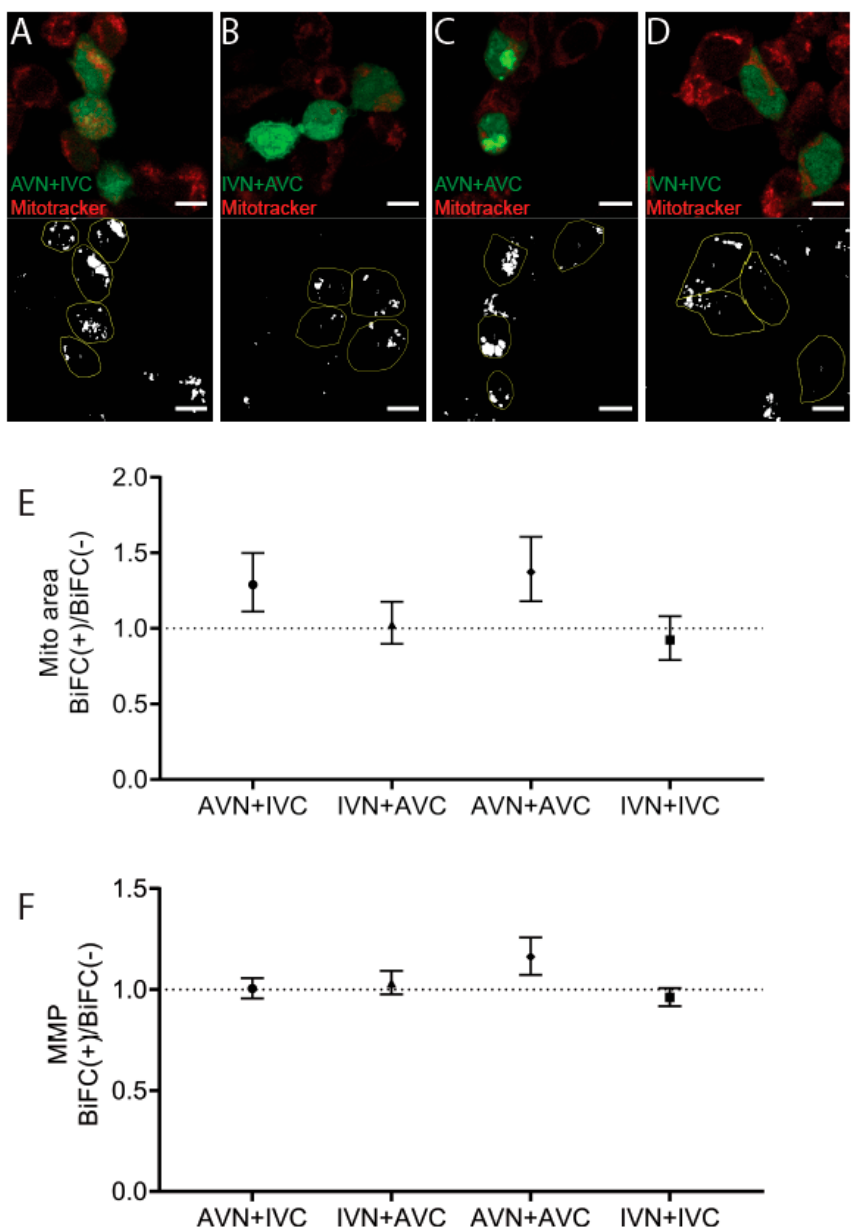
Figure 4. The expression of A β /A β increases the mitochondrial membrane potential. Confocal images of HEK293 cells transfected with ( A ) AVN + IVC, ( B ) IVN + AVC, ( C ) AVN + AVC, and ( D ) IVN + IVC stained with mitotracker (red). Below are the corresponding binary images displaying the cell area (yellow circle) and mitochondrial area (white). ( E ) The ratio of the mitochondrial area in BiFC(+)/BiFC( − ) cells of AVN + IVC, IVN + AVC, AVN + AVC, and IVN + IVC-transfected cells. ( F ) The ratio of MMP in BiFC(+)/BiFC( − ) cells of AVN + IVC, IVN + AVC, AVN + AVC, and IVN + IVC-transfected cells. Scale bar: 10 µm. Results were analyzed by the method of EC Fieller and presented as a mean with a 95% confidence interval.